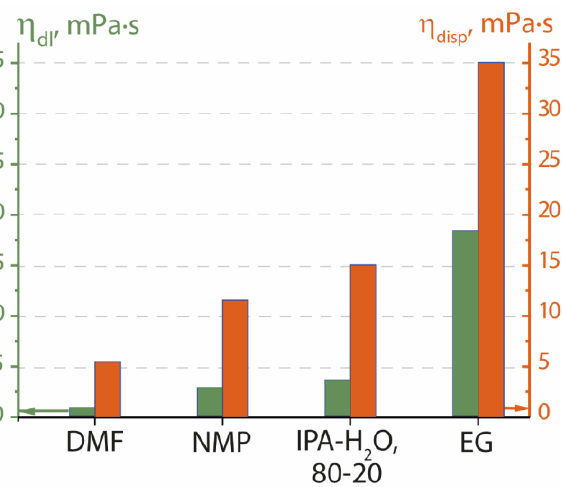
Figure 2. Viscosity of dispersing liquids ( η dl ) and dispersions of Nafion (5 wt.%) in Li + -form ( η disp ) in different liquids.